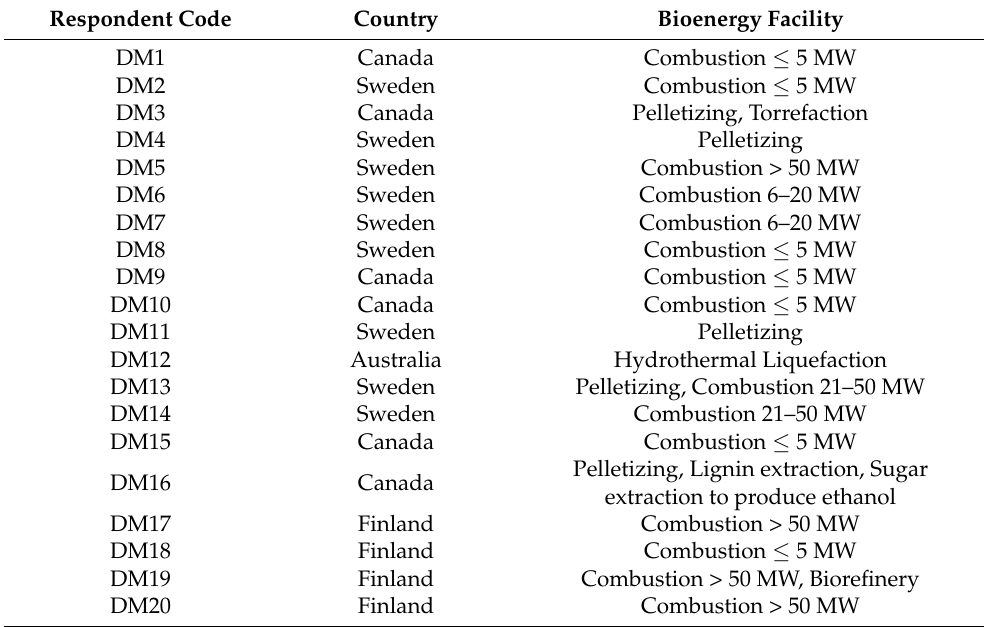
Table A1. Country of origin, biomass conversion technology, and facility capacity, as represented by the respondents to the preference survey ( n = 20).